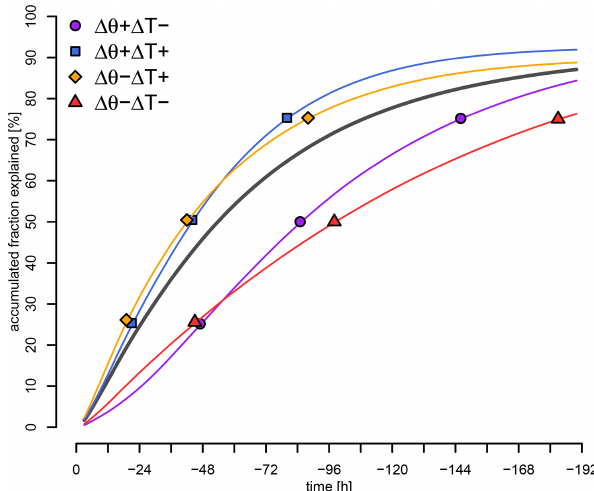
Figure 8. Mean fraction of moisture attributed to moisture up- takes identified along the trajectories between the indicated time and t = 0h for all trajectories during moist-air intrusions (gray) and tra- jectories associated with intrusions in the North Atlantic only in the four trajectory categories (color). Symbols indicate the time when the explained fractions reach 25%, 50%, and